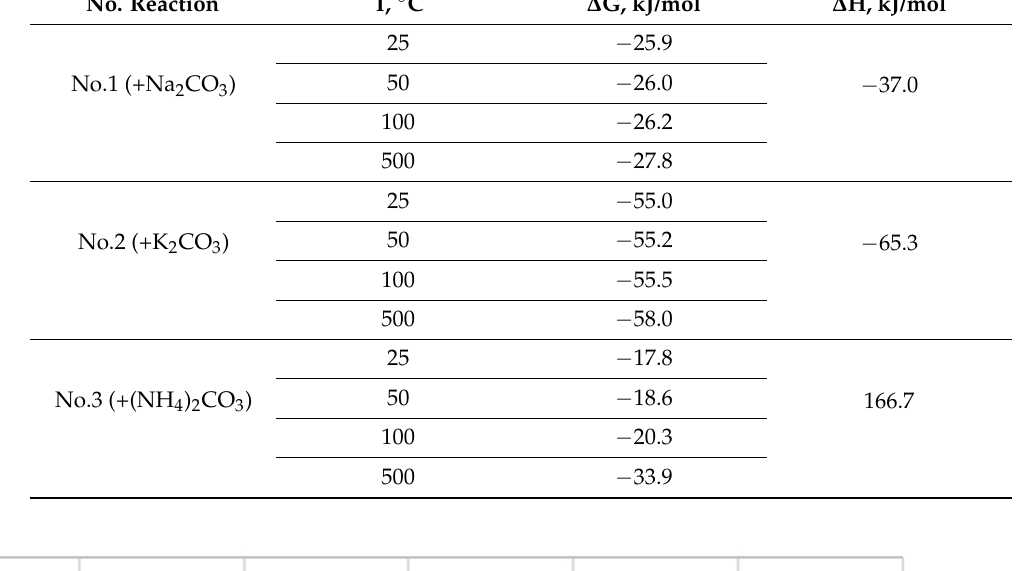
Table 2. Dependence of Gibbs energy change on temperature.